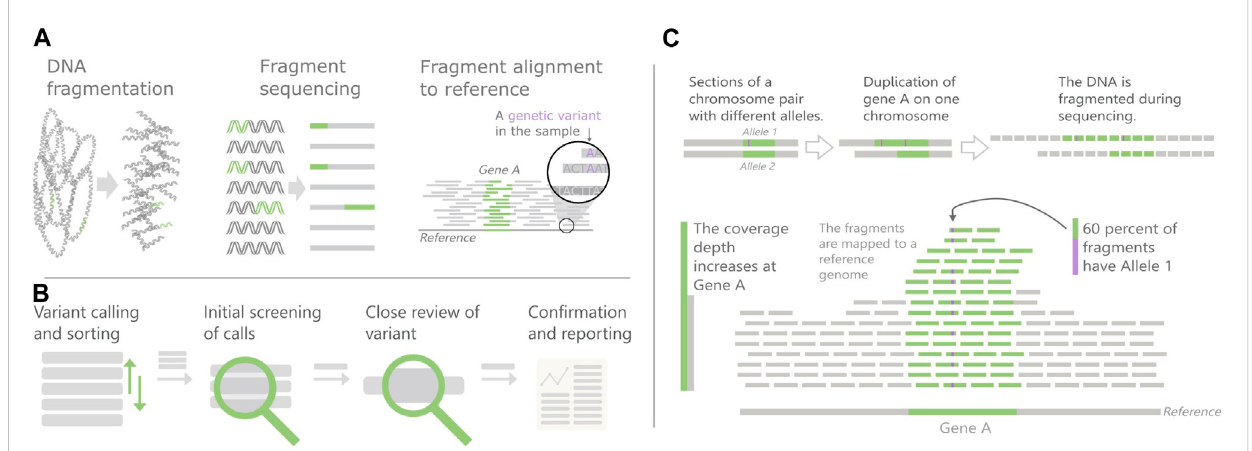
FIGURE 1 Overview of Next-generation sequencing (NGS) and Copy number variants (CNVs). (A) The NGS principles (B) Variant review pipeline, (C) CNV detection in NGS data.CNVs causean increase inthe number of fragments mapped to their area, which can skew the fraction of segments with different